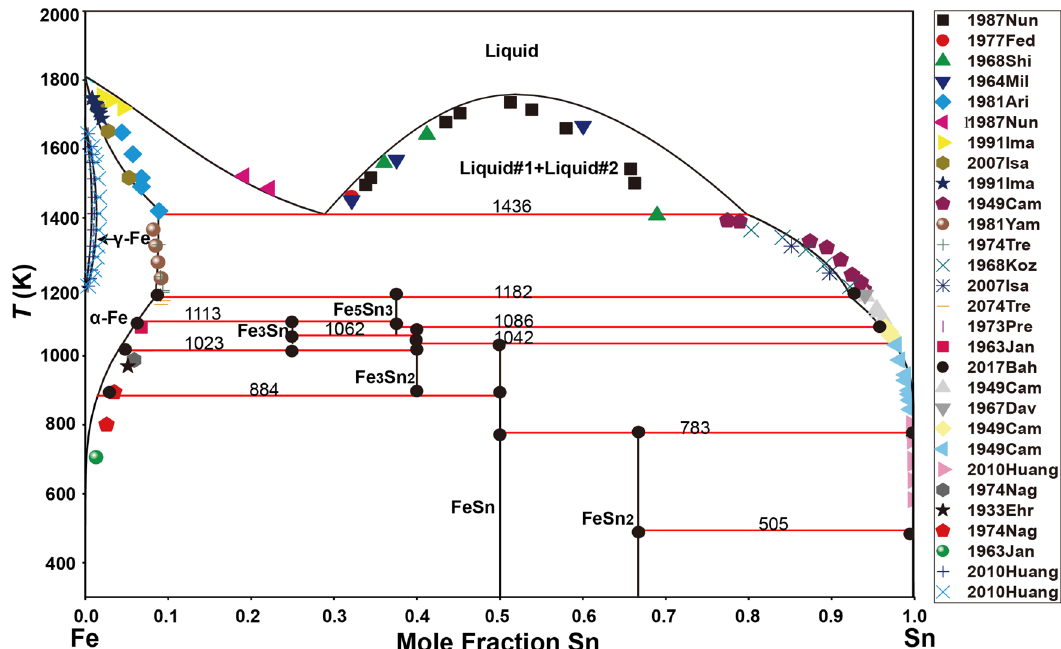
Fig. 3 The optimized Fe – Sn phase diagram based on our thermodynamic modeling. The points correspond to the different experimental data 32,45 – 56 . The red lines indicate the reaction temperatures between the different